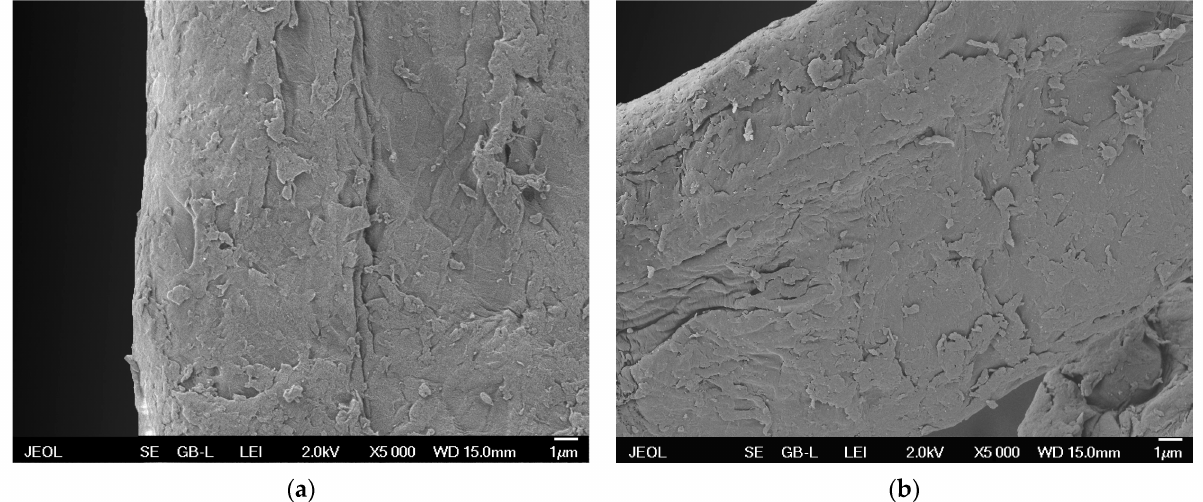
Figure 5. SEM images of ( a ) untreated cellulose fiber (zero sample) and ( b ) functionalized cellulose